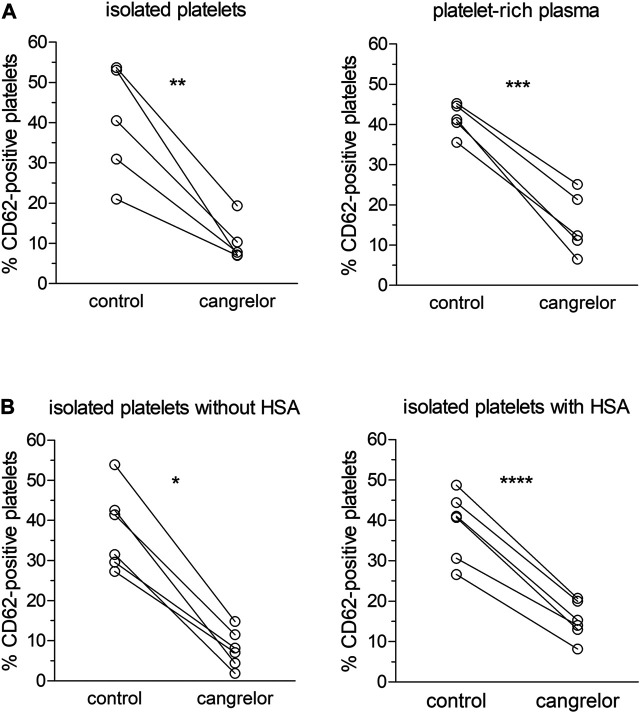
Inhibition of platelet activation by cangrelor. The antiplatelet activity of cangrelor was evaluated in the presence of plasma proteins (A, n = 5) or 4% HSA (B, n = 6) compared to control. PRP or platelet suspensions were pre-incubated with 17 nM cangrelor (3 min, 37°C) and platelet activation was measured by flow cytometry in response to 10 μM ADP. Platelet activation was analyzed on the basis of platelet P-selectin expression (fraction of CD62P-positive cells). Statistically significant differences in platelet response to ADP between the groups were estimated with the paired Student t test or Wilcoxon test. Isolated platelets: µcangrelor ≠ µcontrol (p < 0.01), platelet-rich plasma: µcangrelor ≠ µcontrol (p < 0.001), isolated platelets without HSA: µcangrelor ≠ µcontrol (p < 0.05), isolated platelets with HSA: µcangrelor ≠ µcontrol (p < 0.0001).